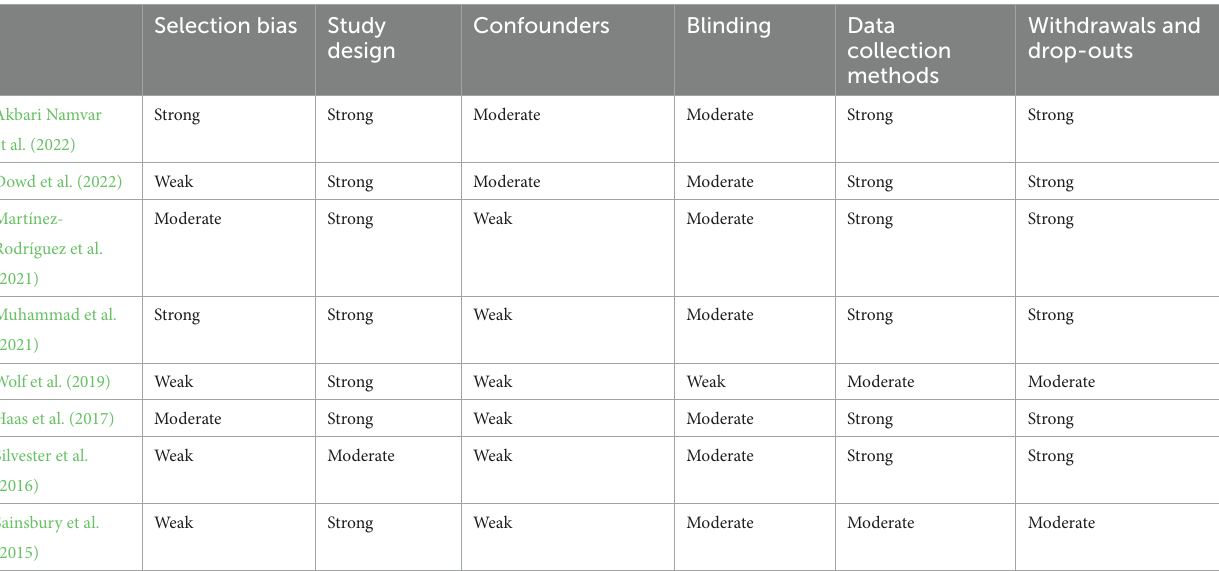
TABLE 5 Quality assessment